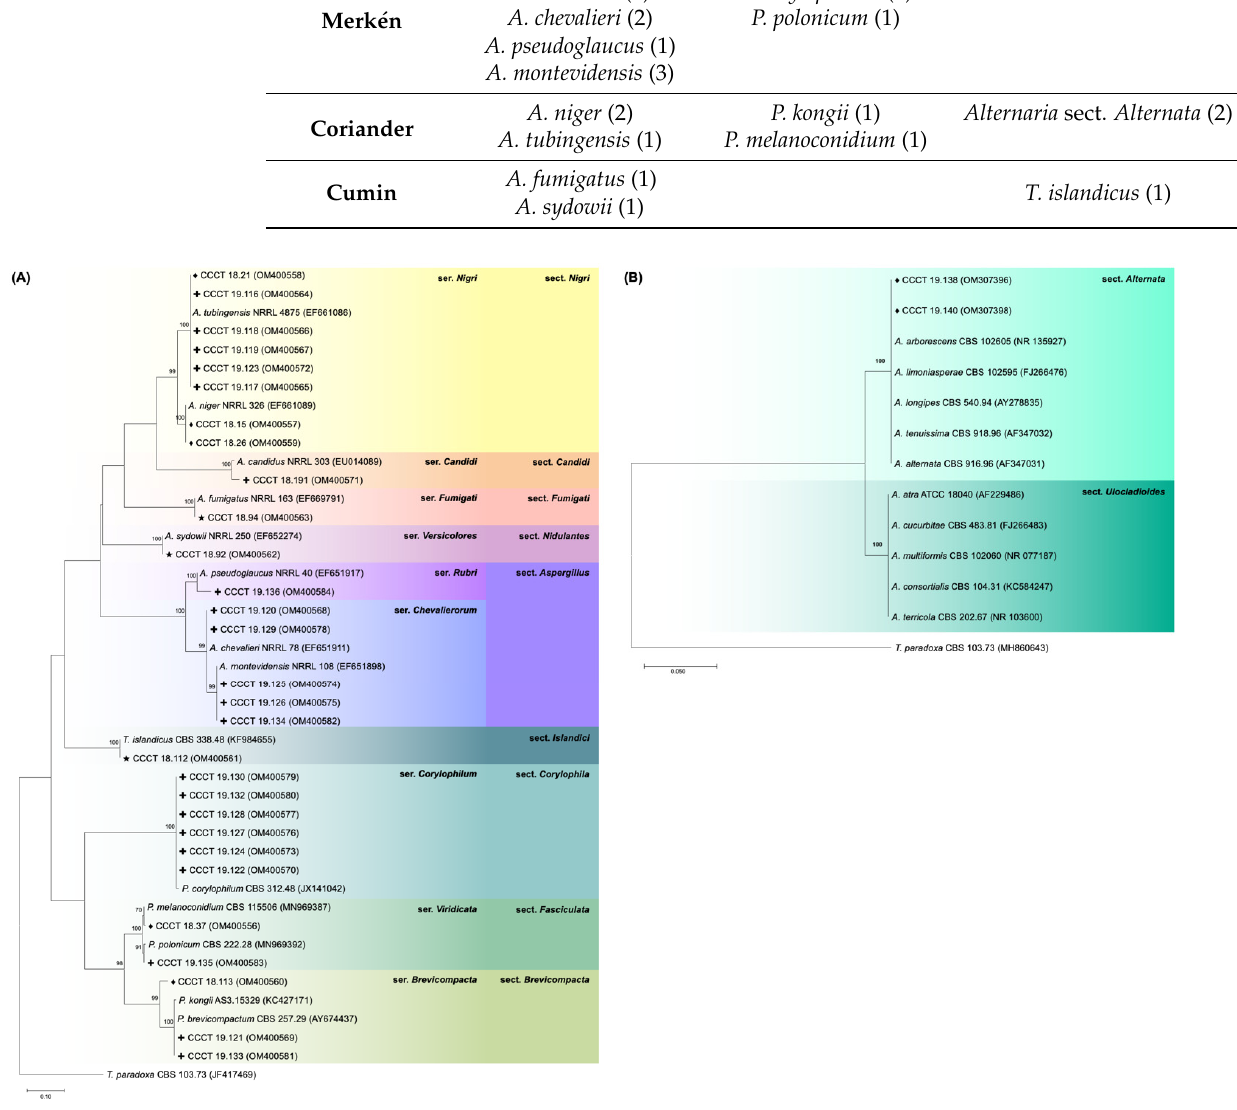
Figure 2. Phylogenetic analyses of benA and ITS sequence data of the 31 strains isolated from SP IV (coriander ♦ , cumin ) and SP V (Merkén + ) samples collected in the region of La Araucanía, Chile. GenBank accession codes are indicated in parenthesis. Trichocoma paradoxa CBS 103.73 was used as an outgroup. The percentage of trees in which the associated taxa cluster together in the bootstrap test (1000 replicates) is shown above the branches. The trees are drawn to scale with branch lengths measured in the number of substitutions per site. All positions with less than 95% site coverage were eliminated. ( A ) benA phylogenetic tree including Aspergillus , Talaromyces , and Penicillium strains. Selected model: K2 + G + I. The final dataset included 44 nucleotide sequences and a total of 251 positions. ( B ) ITS phylogenetic tree of Alternaria strains. Selected model: K2. The final dataset included 13 nucleotide sequences and a total of 426